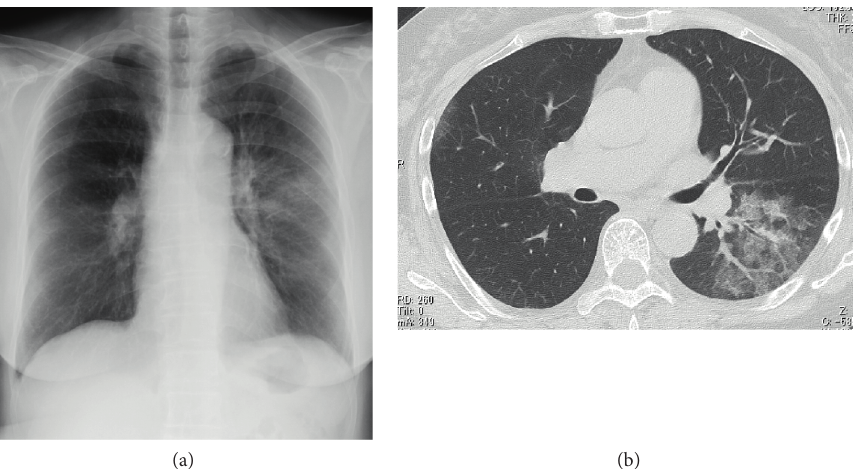
Figure 1: (a) Chest radiography shows subtle pulmonary infiltrate in the left lung. (b) Computed tomography (CT) reveals pulmonary infiltrates with ground-glass opacities (GGO) in the superior segment (S6) of the left lung.